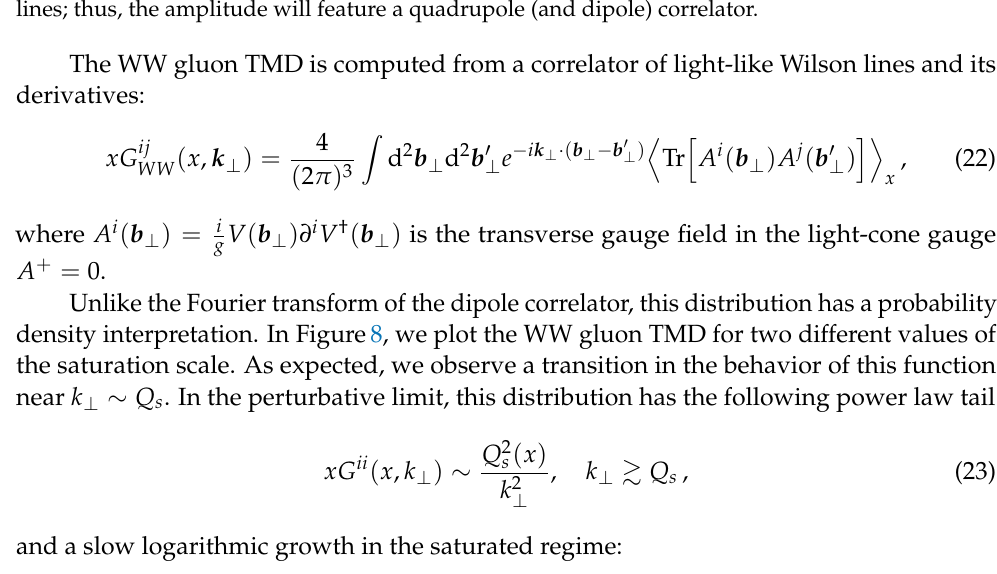
Figure 7. Feynman diagram for the amplitude in virtual photon-nucleus collisions. The amplitude contains the production of two light-like Wilson lines; thus, the amplitude will feature a quadrupole (and dipole)